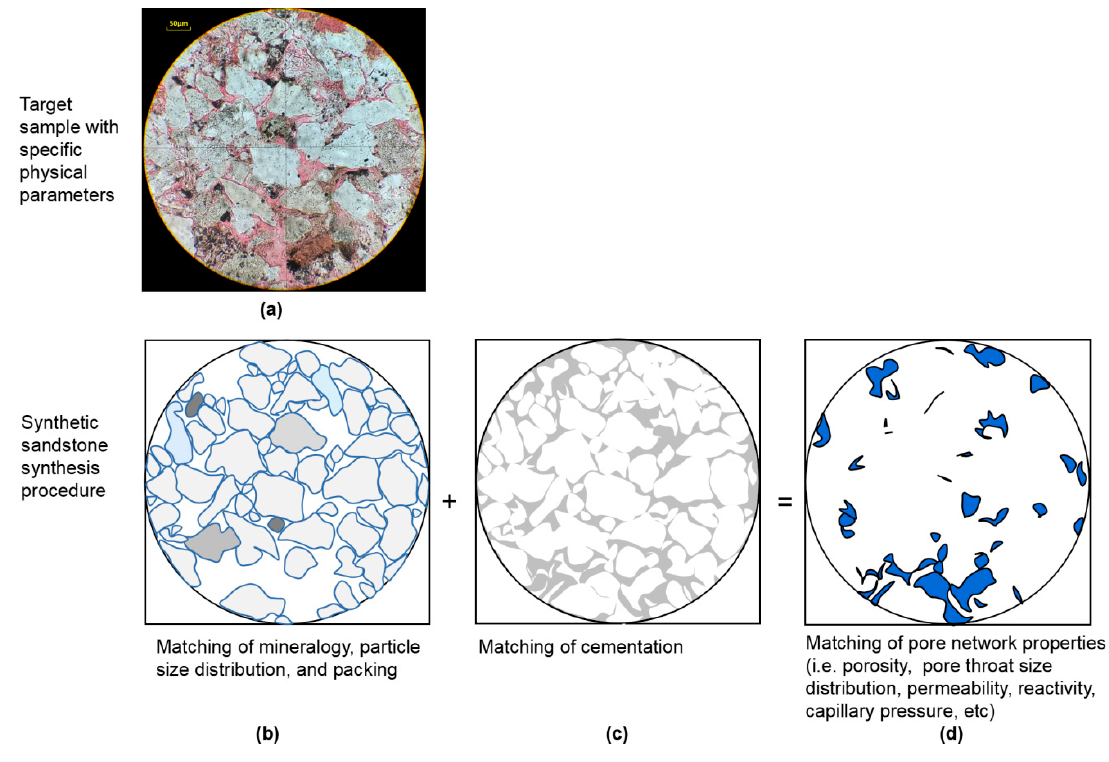
Figure 1. ( a ) Thin section of target natural sandstone sample 7-1 incorporating the four independent fundamental physical parameters of particle size distribution, packing, cementation, and mineral composition. Synthetic sandstone synthesis procedure with ( b ) match of particle size distribution (particle size distribution (PSD); shown in gray), mineral composition, packing, and ( c ) Match of cementation level (shown in gray) resulting in ( d ) match of pore network (shown in blue), and its derived pore network-associated properties.